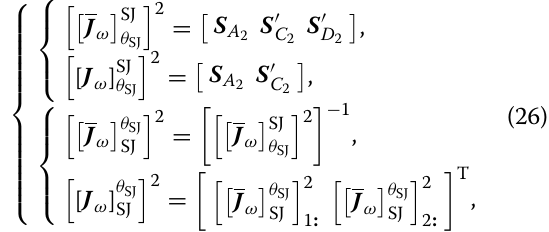
(a) Three-dimensional model of the HWJ